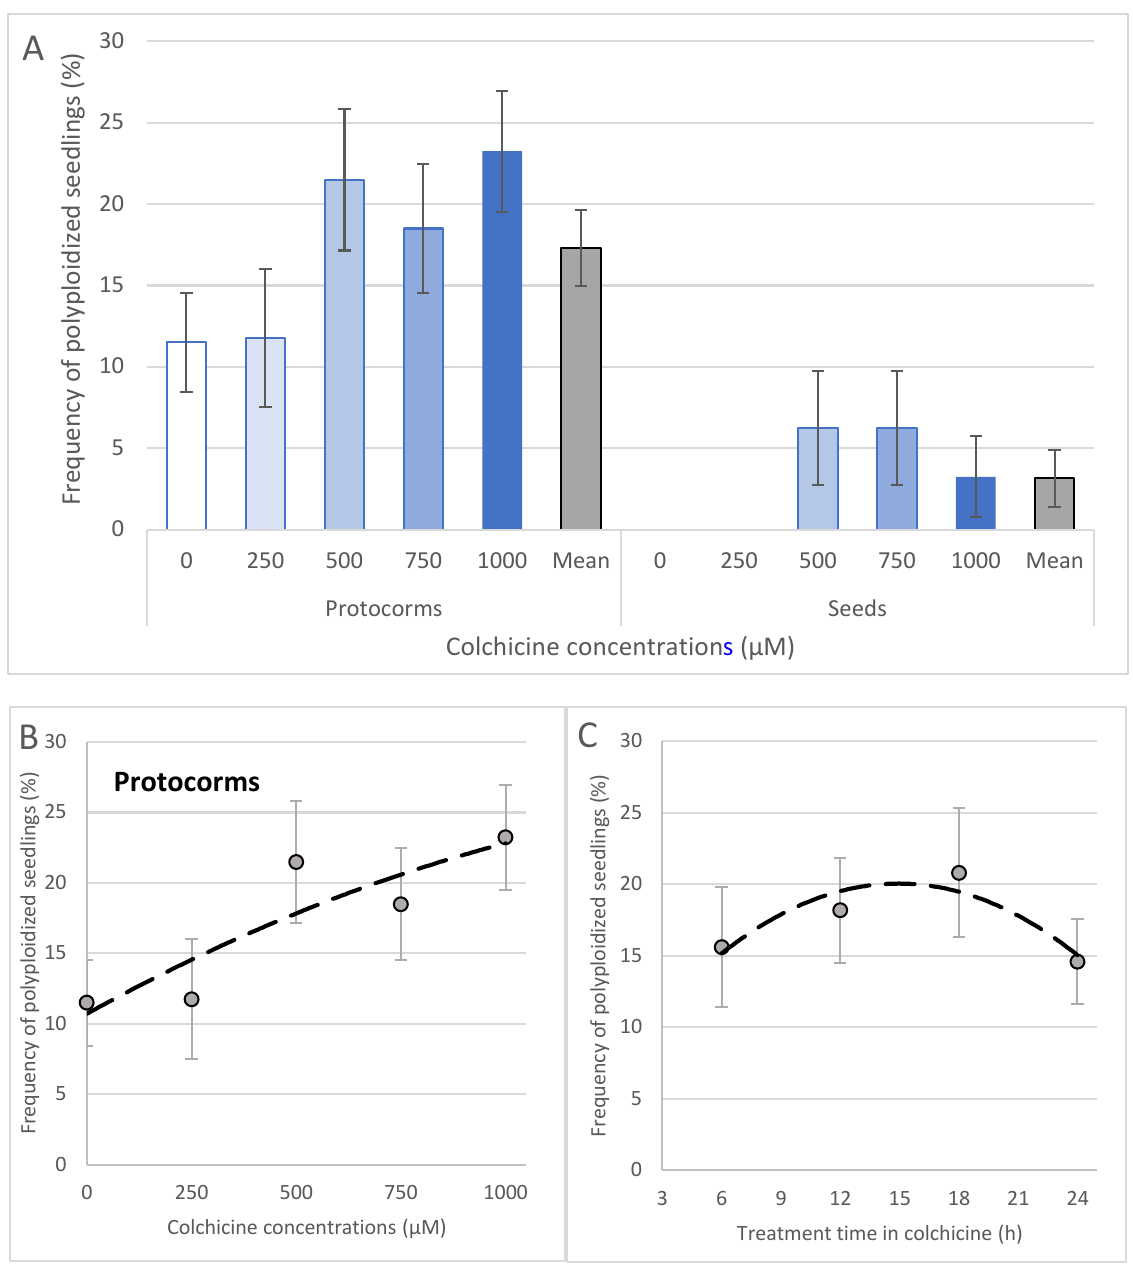
Figure 7. Polyploidy frequency in seedlings of Blc . hybrid. The type of the explant and concentration of colchicine in the frequency of polyploidization ( A ) and correlation with concentrations ( B ) and treatment time ( C ) in protocorms treated with colchicine. The Student’s t -test showed significant values of coefficient of correlation (r) (0.05*) for protocorms (treatment time and colchicine concen- tration) and for seeds (only for colchicine concentration). Equations and r values: (B) y = -4 × 10 -6 x 2 + 0.0164x + 10.714, r = 0.882*; (C) y = −0.0611x 2 + 1.8267x + 6.4, r = 0.913*.